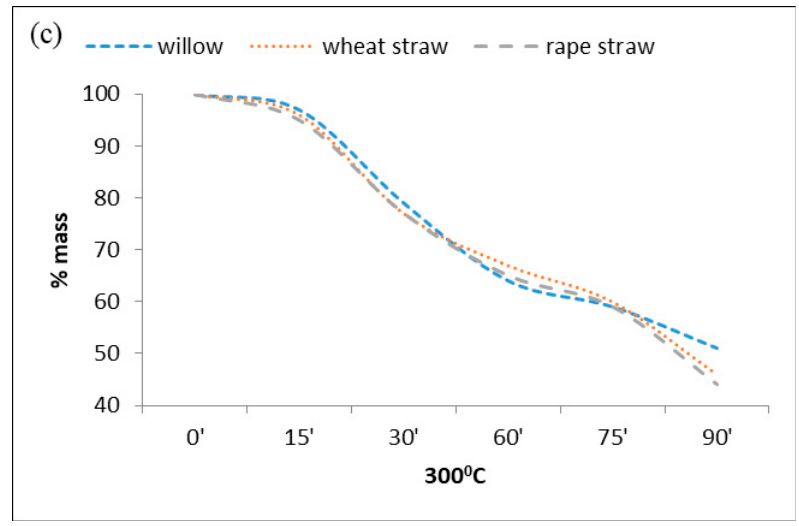
Figure 1. Loss in weight of biomass at different times: 220 °C ( a ), 260 °C ( b ), and 300 °C ( c ).